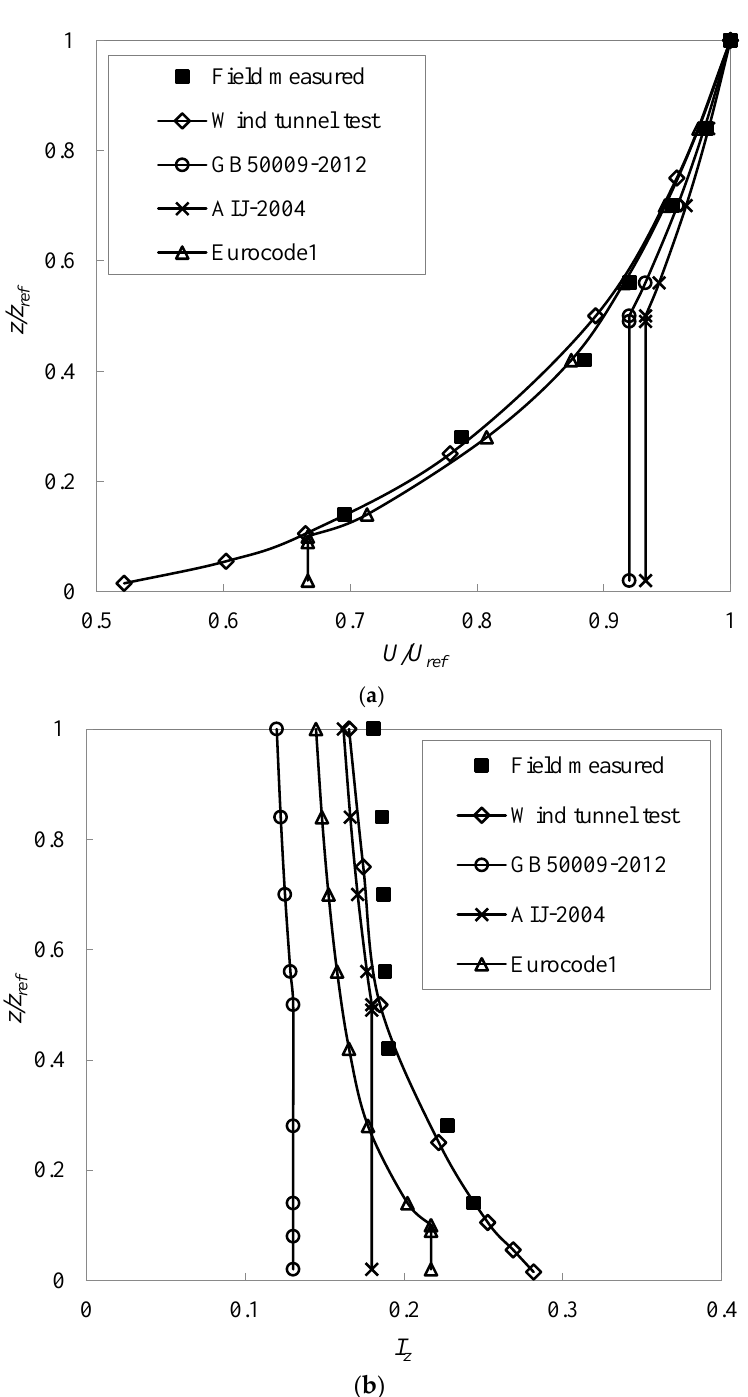
Figure 5. Wind tunnel simulation: ( a ) Wind profiles; ( b ) Turbulence intensities. Based on the measured results of sand collection in most previous studies [3,30,31] and the actual height of the existing infrastructures and civil structures in desert regions, the wind tunnel tests are designed to replicate the first 10 m of the surface layer. By comparing the measured height in desert regions with the size of the wind tunnel test section, the geometric scale ratio is chosen to be 1:10. It is difficult to consider the geometric scaling of sand particles because the particle size is less than 1 mm. Therefore, according to the existing windblown sand tests [33,35,40,44,45], we ignored the influence of the geometric scaling of sand particles on the results. The impurity-free wind flow field